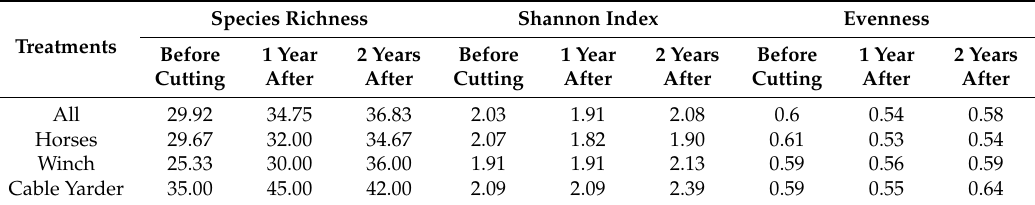
Table 6. Floristic species diversity indexes for the studied areas.